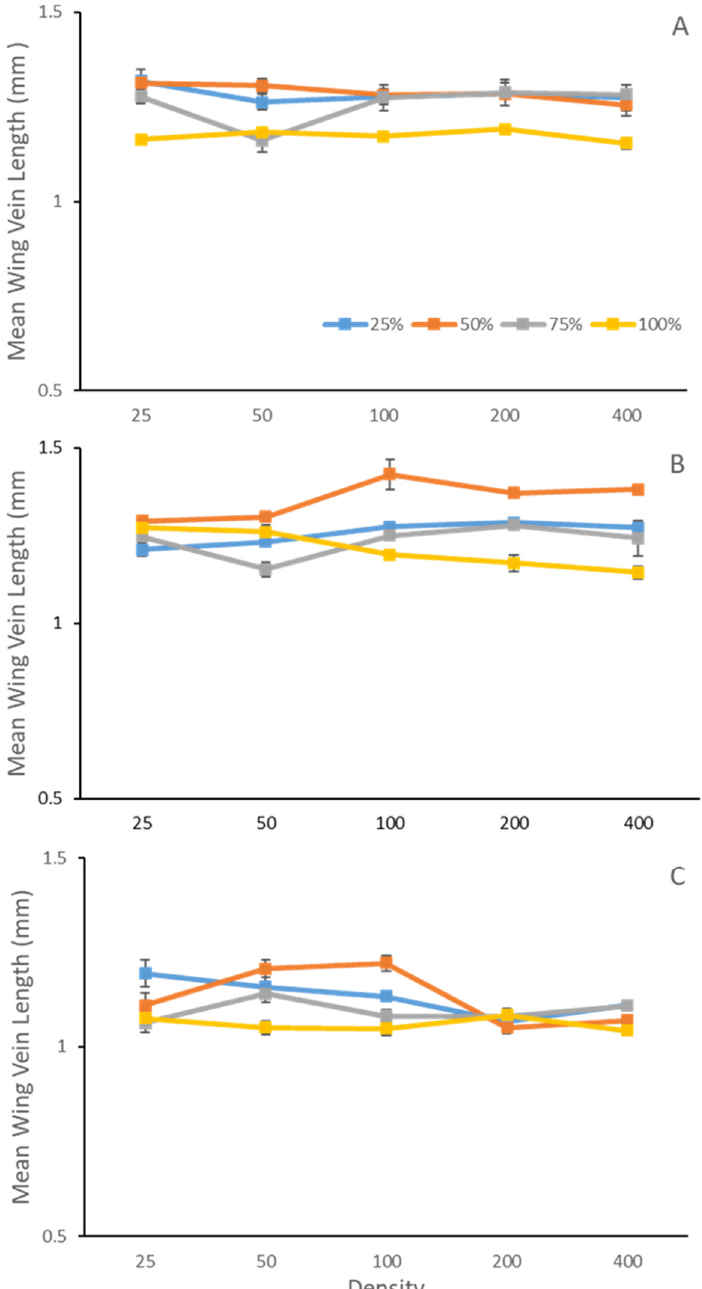
Figure 2. Mean ± SE adult body size of Lucilia sericata Meigen (Diptera: Calliphoridae) (as measured by the length of the posterior cross-vein to dm-cu vein of the left wing) reared within larval ratios of 100% L. sericata , 75% L. sericata to 25% Phormia regina Meigen (Diptera: Calliphoridae), equal 50:50 ratio, or 25% L. seriata to 75% P. regina at ( A ) 15 ◦ C, ( B ) 25 ◦ C, and ( C ) 35 ◦ C across densities (larvae/jar). Adult body size was influenced by an interaction between species treatment, density, and temperature (F 3,997 = 8.54, p <